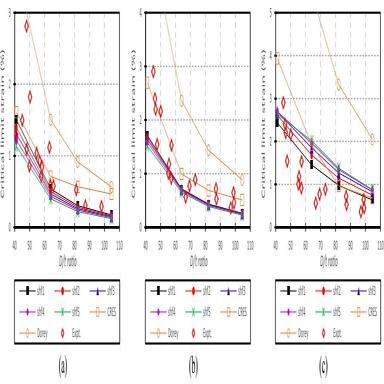
Comparison of CLS models with experimental test results for YPT X60 pipe. (a) fp = 0.0, (b) fp = 0.4, and (c) fp = 0.8.